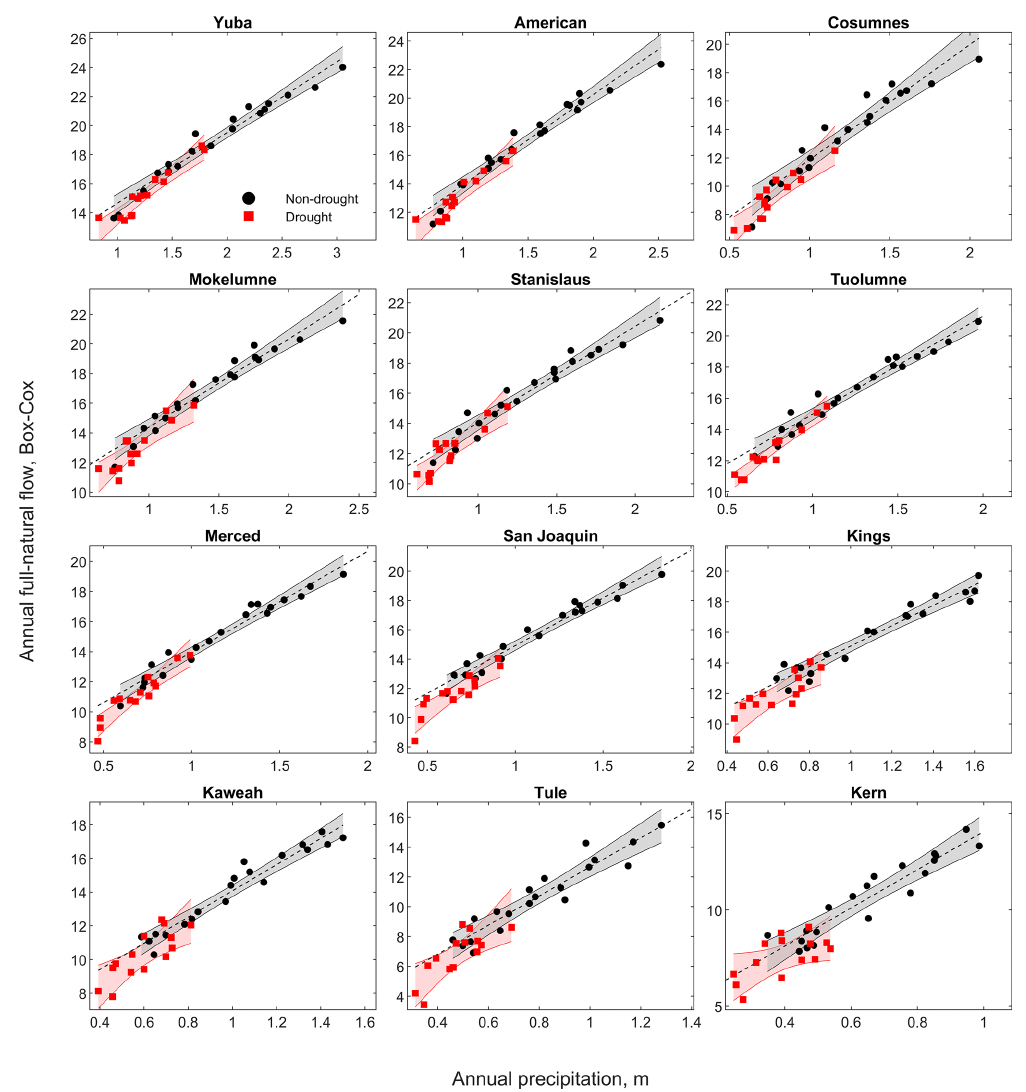
Figure 9. Precipitation–runoff relationship for drought (red) vs. non-drought (black) years and the 12 (main) basins draining the western side of the Sierra Nevada to the California Central Valley in addition to the Feather River. Panels are organized by the most northern river in the upper left to the most southern river in the lower right. The red and grey bands represent 95% confidence intervals for the